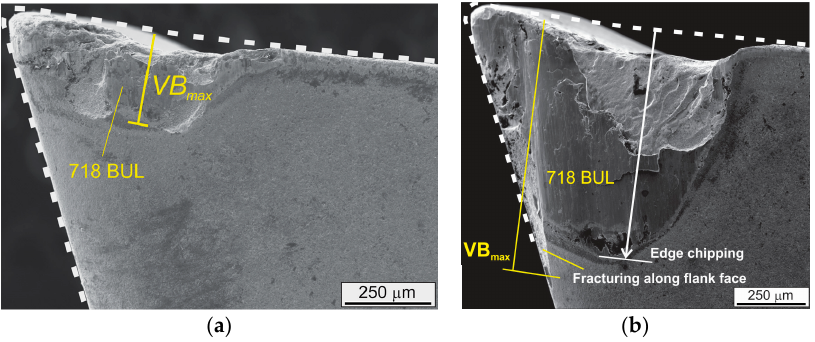
Figure 7. Scanning electron microscope (SEM) images of Tool wet2 side flank face with zero pass edge outline (ZPEO): ( a ) after the second pass, and ( b ) after the third pass.